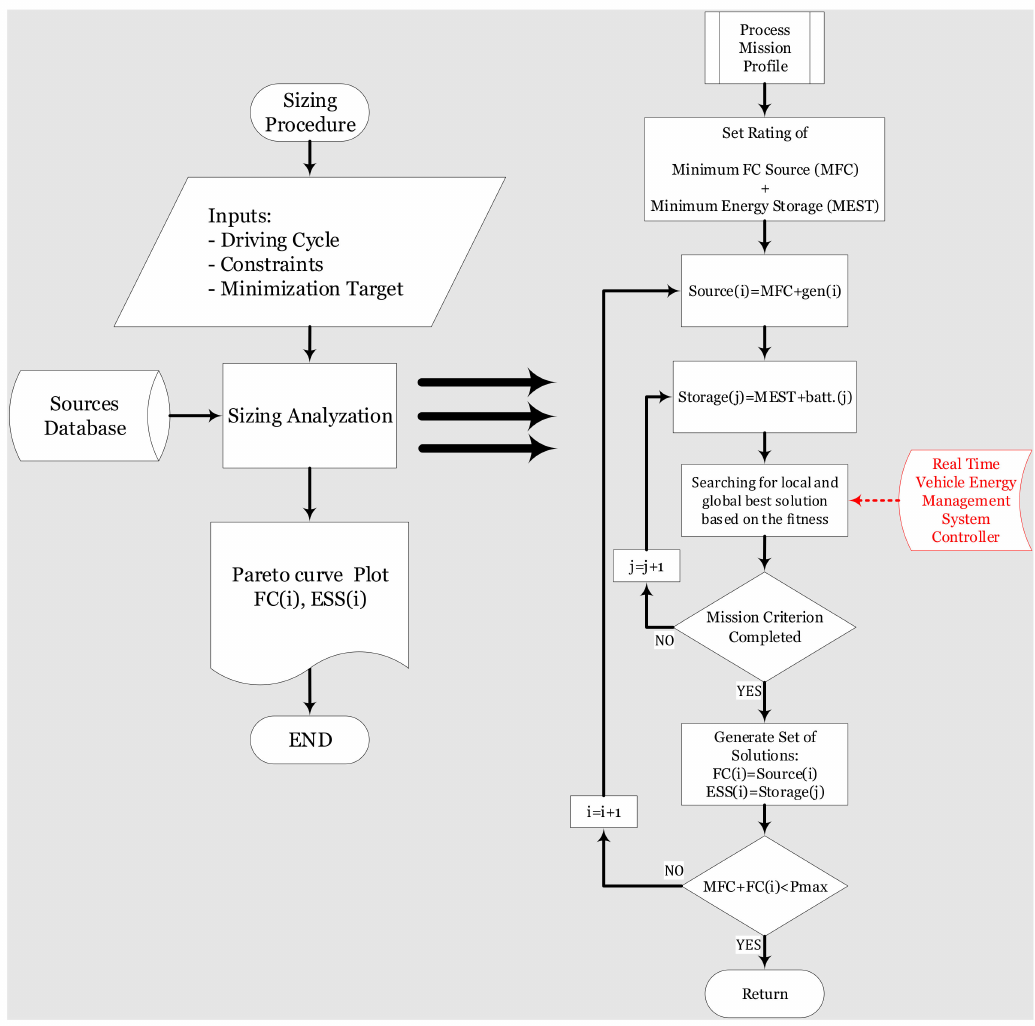
Figure 12. Generic sizing